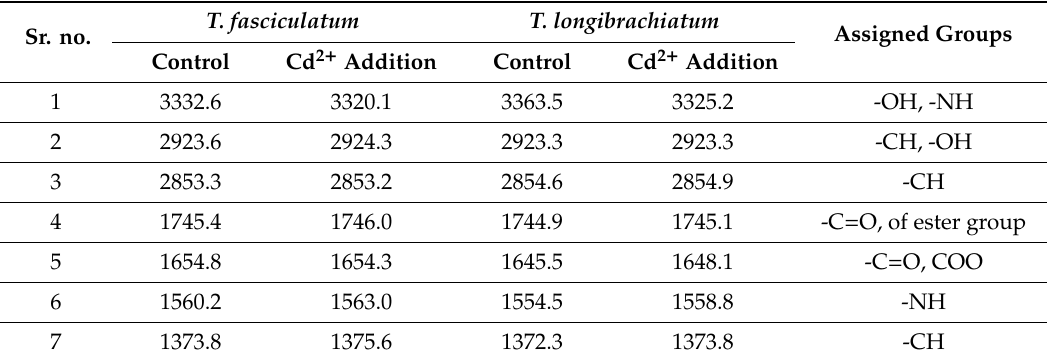
Table 3. FTIR peaks and their corresponding functional groups of T. fasciculatum and T. longibrachiatum before and after the addition of Cd 2 +